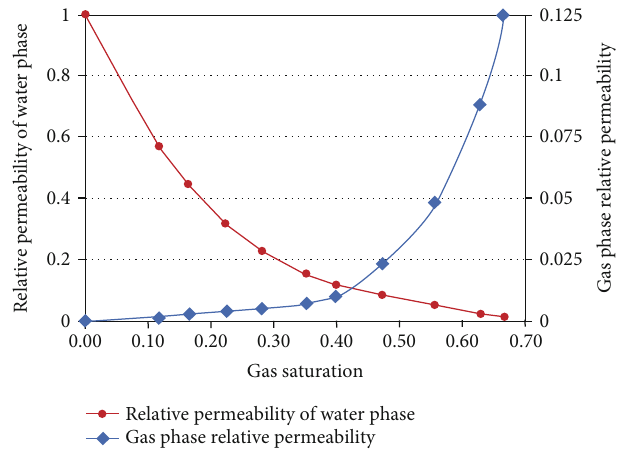
Figure 12: Gas-water relative permeability curve in dual medium. Table 3: Relative permeability curves for reality and modi fi cation.